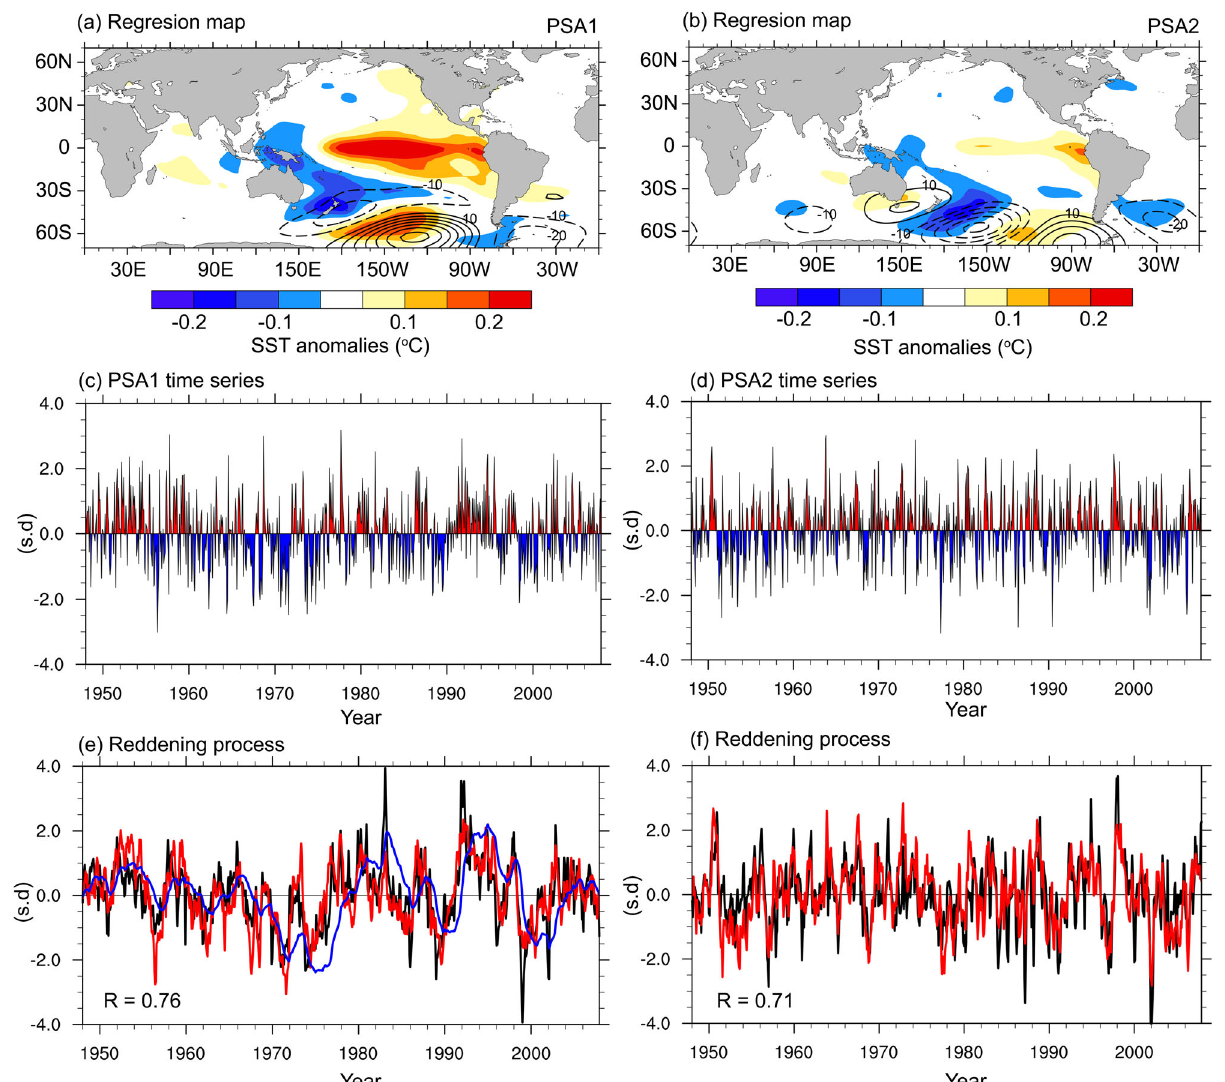
Fig. 1 Atmospheric forcing of the leading two SST modes in the South Paci fi c Ocean. The PSA1 ( a ) and PSA2 ( b ) patterns are obtained by regressing the monthly near-global Z500 anomalies (NCEP-NCAR; contour) and monthly SST anomalies (ACCESS-O; shade) onto the PSA1 and PSA2 time series, respectively. c , d The corresponding normalised PSA1 and PSA2 time series. e , f The time series of the leading two SST modes of variability in the South Paci fi c Ocean (ACCESS-O; black) are reconstructed (red) using an AR1 model forced by the PSA1 and PSA2 time series. The blue curve in ( e ) indicates the second integration forced by the SST SPDO time series. The units are in standard deviations (s.d.). The signi fi cance of the temporal correlations is estimated taking account of the effective number of degrees of freedom due to serial correlation 48